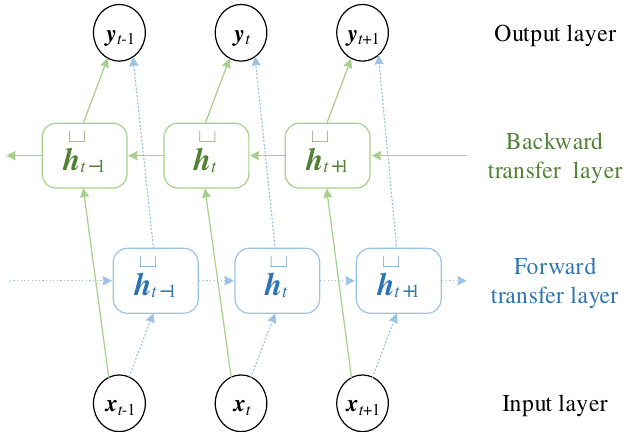
Figure 6. Schematic of Bi–LSTM network structure.